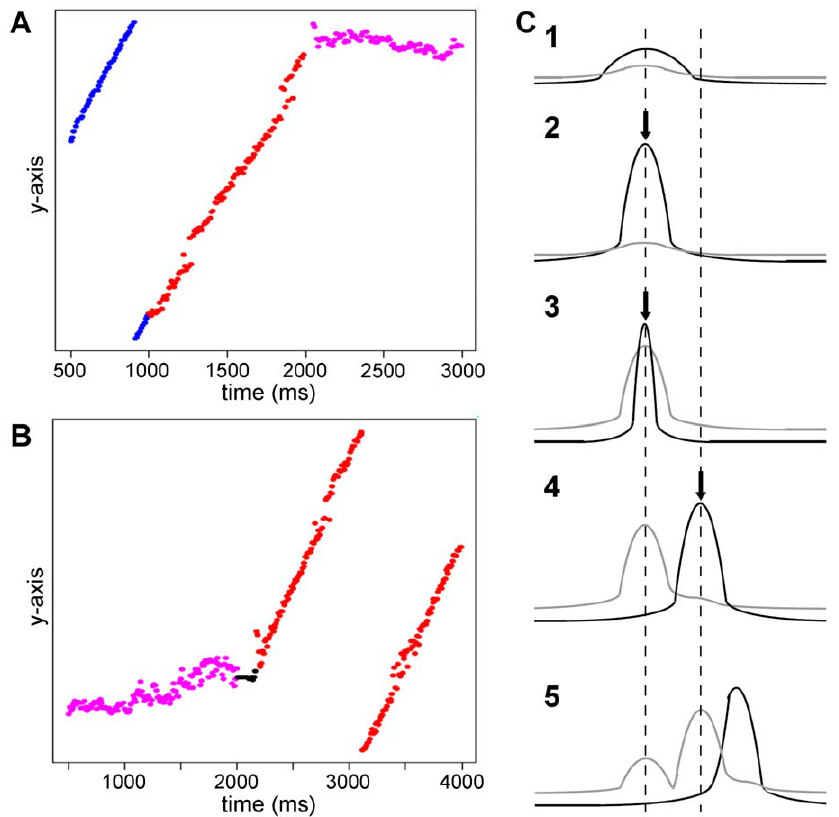
Figure 6. Bidirectional switching of bump mode in the noisy background condition. (A, B) The positions of the bumps in a linear strip (periodic boundary condition) are plotted versus time. Constant, t d , was set to 200 ms. (A) A simulation run started out in the noiseless background condition and remained in the condition until t ~ 1000 ms (blue dots), and the noisy background condition ( s noise ~ 23 : 5 pA) started and continued until t ~ 2000 ms (red dots). Finally, a transient strong inhibition was applied globally from 2000 ms to 2050 ms, and the bump was immobilized (magenta dots). (B) A simulation run started out in the noisy background condition ( s noise ~ 23 : 5 pA) (magenta dots), and at 2010 ms, a transient strong excitatory input lasting 50 ms was applied on a thin vertical line at the center of the bump. Immediately following the excitatory input, another excitatory input was applied for 10 ms on a thin vertical line adjacent to the previously applied position. This combined excitation (black dots) switched a bump mode from an immobile one (magenta dots) to a moving one (red dots). (C) Schematic figure explaining how an immobile bump starts moving after the combined excitation is applied. Each panel from C1 to C5 show each stage of a process of starting for the bump to move. Somatic activity is depicted with the black curve. The influence of inhibitory effects due to somatic K z currents and the feedback inhibitory synaptic currents collectively is depicted with the gray curve. Arrows indicate the external application of the first (in C2 and 3) and the second (in C4) excitatory inputs. For more detail, see main